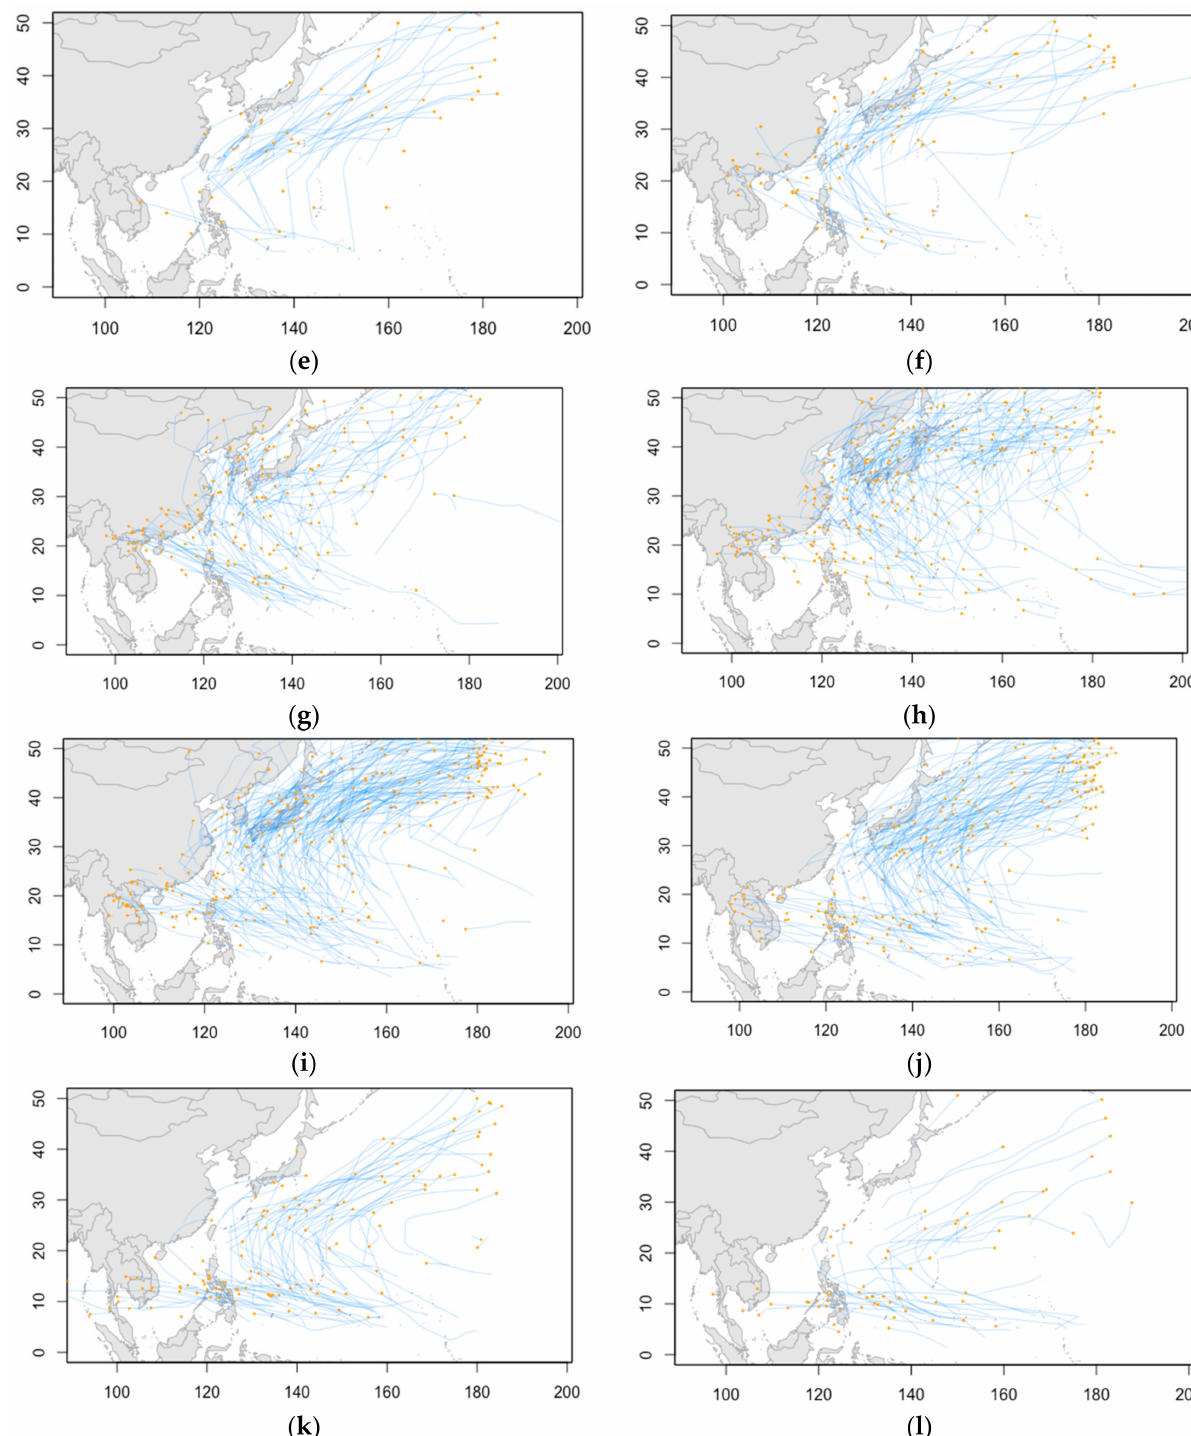
Figure A1. Distribution of WNP region observed typhoon activities in ( a ) January, ( b ) February, ( c ) March, ( d ) April, ( e ) May, ( f ) June, ( g ) July, ( h ) August, ( i ) September, ( j ) October, ( k ) November and ( l )